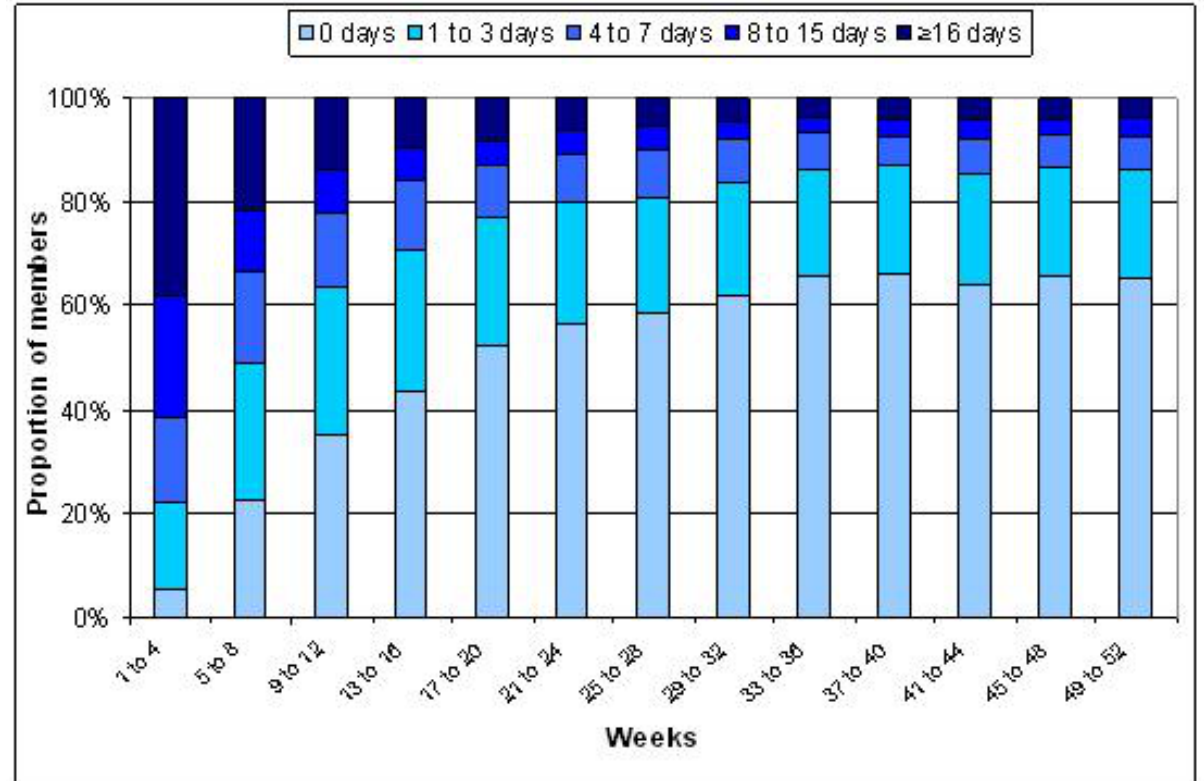
Figure 3. Website use from enrollment to 52 weeks among 52 week subscribers